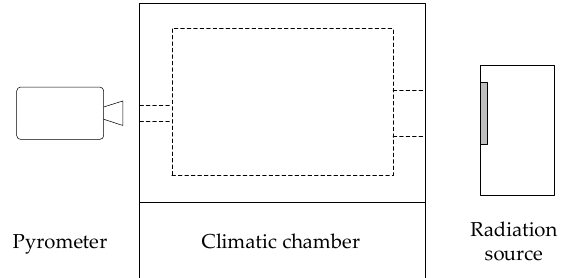
Figure 7. Sketch of the validation experiment.